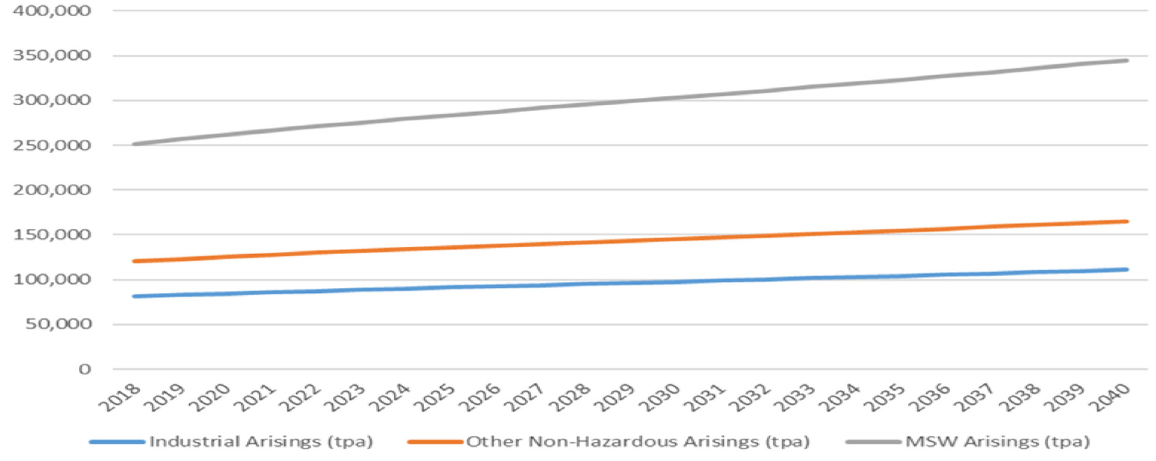
Fig. 3. The growth of three waste streams in Ajman until the year 2040 (Ajman (cid:1)